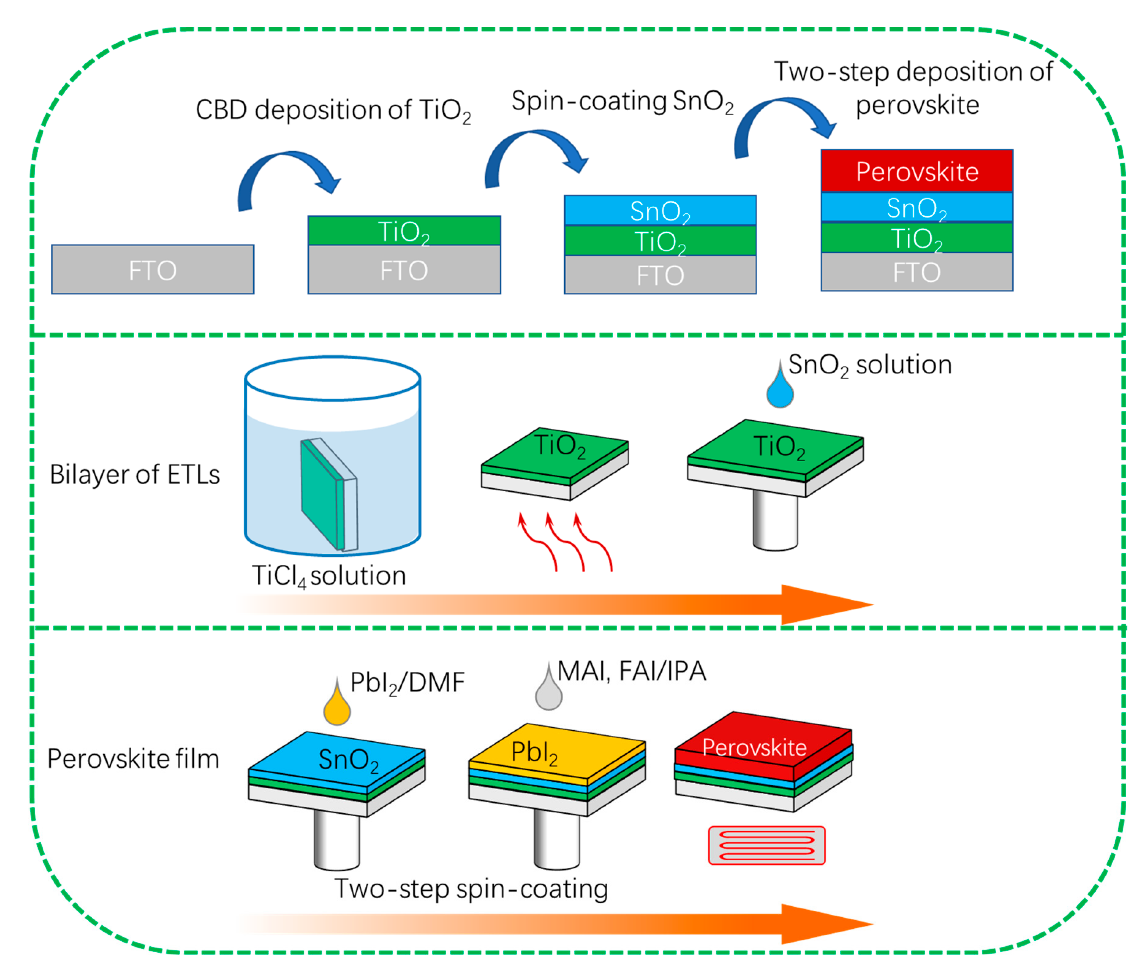
Figure 1. Schematic illustration of the bilayer of ETLs (TiO 2 and SnO 2 films) and perovskite films fabricated by chemical bath deposition and spin-coating. fabricated by chemical bath deposition and